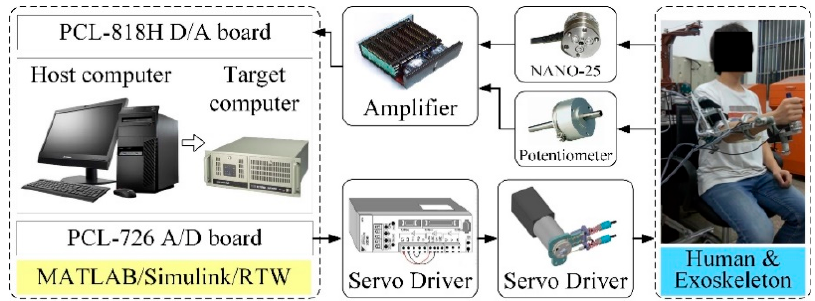
Figure 3. Matlab/Real-Time-Workshop/xPC control system.